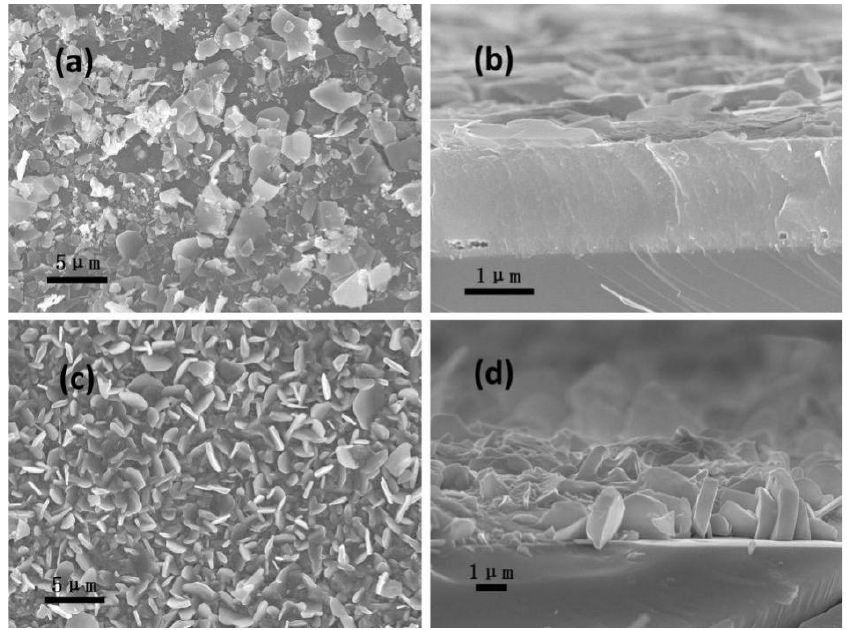
Figure 8. Surface ( a , c ) and cross-sectional ( b , d ) morphology of CrSiN coatings deposited at arc currents of 70 A and oxidized at 800 ◦ C ( a , b ), and 900 ◦ C ( c , d ).